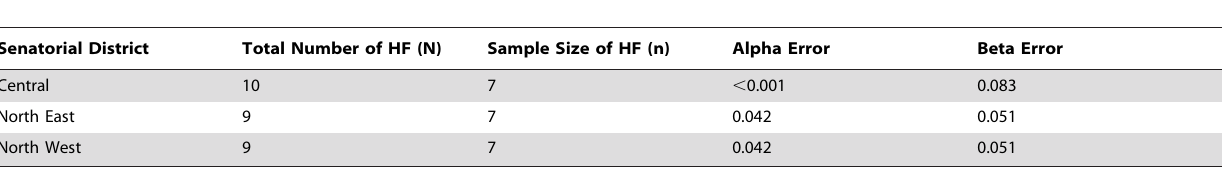
Table 1. Jigawa State with Three Senatorial Districts by Total Number of Health Facilities (HF), PMVs, Sample Sizes, and Alpha and Beta Errors for an LQAS Decision Rule of ‘‘d’’ =5.